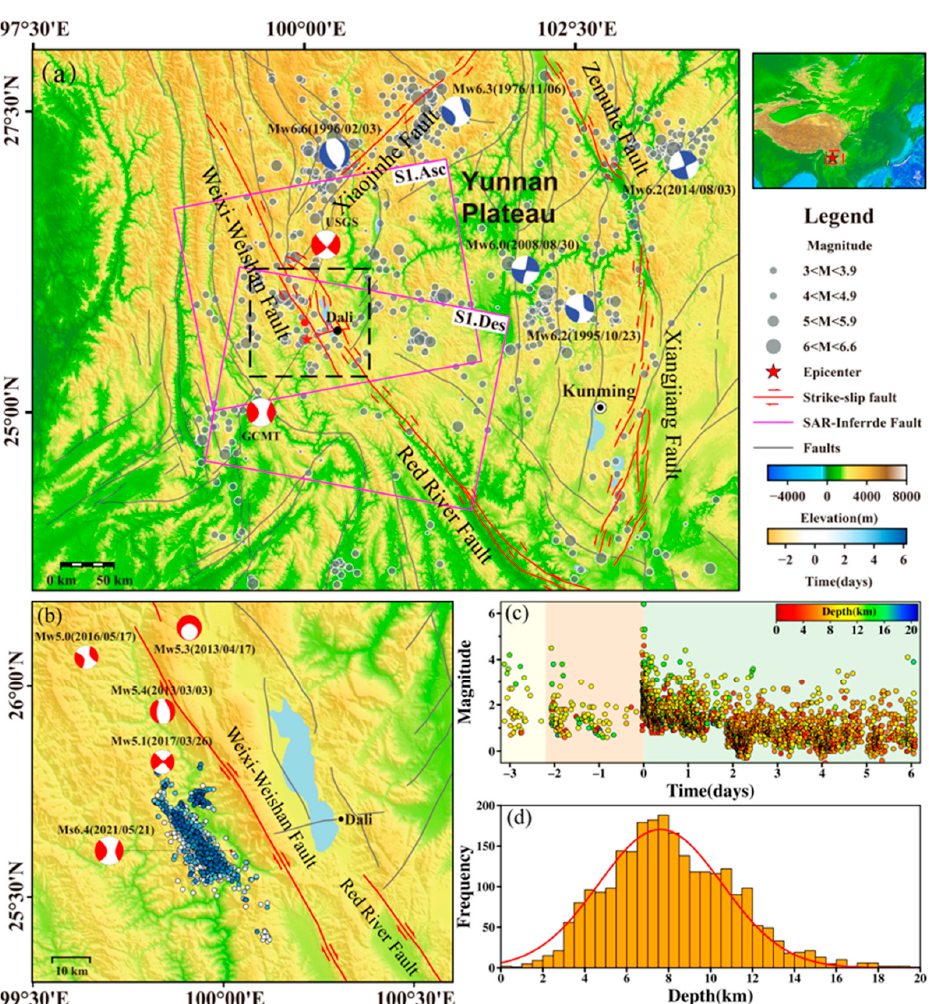
Figure 1. Tectonic setting of the seismogenic area of the 2021 Yangbi earthquake. ( a ) Coverage of the Sentinel-1 SAR data in the study area. Red dot and star represent the epicenters given by USGS and GCMT, respectively. Red beach balls show the focal mechanism solutions (FMS). Gray circles display the distribution of historical earthquakes ( 𝑀 > 3.0) from GCMT since 1976. Blue beach balls denote the FMS of 𝑀 > 6.0 historical earthquakes. Thin grey lines and thick red lines are the regional active faults and the typical strike-slip faults, respectively [ 13 ] . Magenta boxes show the spatial frames of the Sentinel-1 SAR data on ascending and descending tracks. Black dotted box shows the region in ( b ). ( b ) Topographic and active faults map surrounding the Yangbi event. Red beach balls represent the FMS and epicenter locations of 𝑀 > 5.0 earthquakes since 1976. The distributions of the shocks occurred three days before and six days after the mainshock are shown by color-coded circles. ( c ) the magnitude-time evolution of the fore- and after-shock sequence by depth-dependent color-coded circles. ( d ) the depth frequency of the fore- and after-shocks.